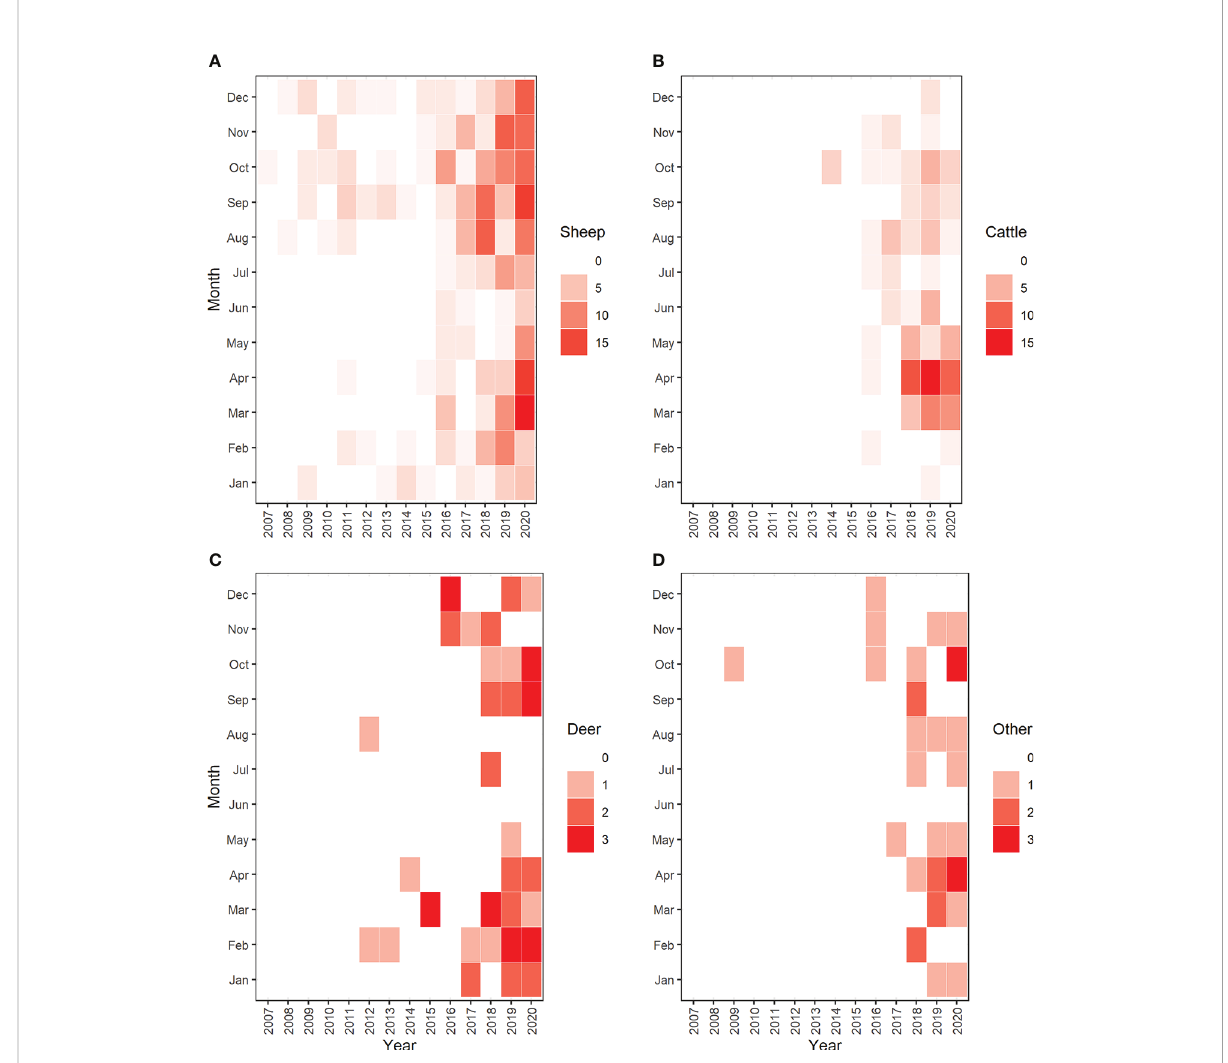
FIGURE 6 Yearly and monthly distribution of reported wolf predation events on (A) sheep, (B) cattle, (C) farmed deer, and (D) other livestock species in Brandenburg State